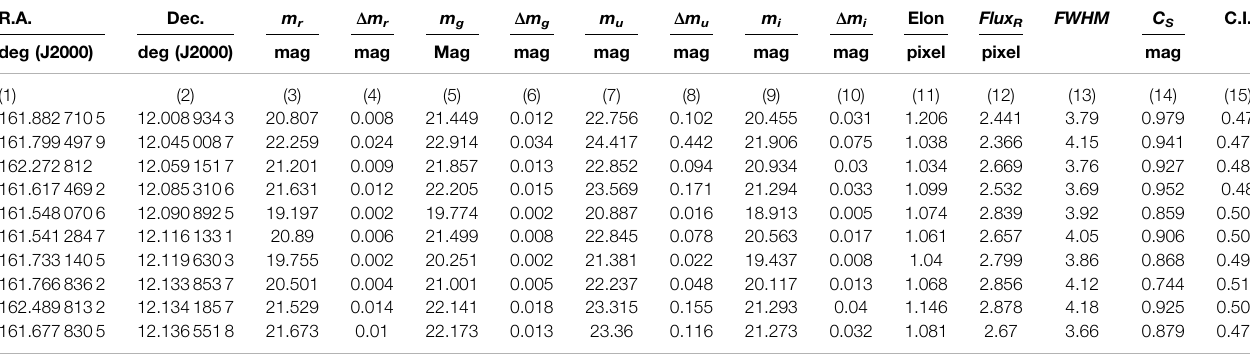
TABLE6| SelectedGCscatalog:Col.(1-2)R.AandDec.indegrees(J2000),Col.(3-4)magnitudesanduncertaintiesinthe r band,Col.(5-6)magnitudesanduncertaintiesin the g band, Col. (7-8) magnitudes and uncertainties in the u band, Col. (9-10) magnitudes and uncertainties in the i band, Col. 11) is the Elongation parameter from SExtractor de fi ned as the ratio between the major and minor axis of the sources, Col. 12) is the Flux Radius parameter from SExtractor which is the radius containing half of the fl ux from the sources, Col. 13) is the FWHM parameter from SExtractor, Col. 14) is the Class Star parameter from SExtractor which classify sources, Col. 15) is the Concentration Index de fi ned as the difference between magnitude at difference aperture, in particular we did the difference between 4-pixel aperture magnitude and 6- pixel one.